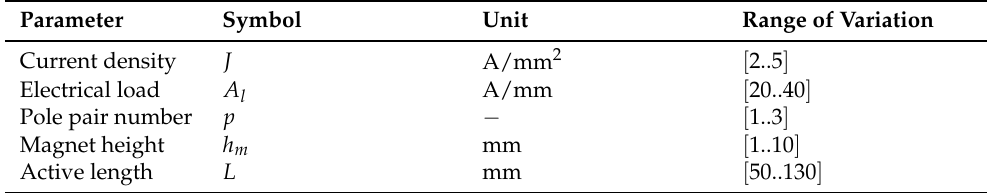
Table 4. Range of variation of optimization